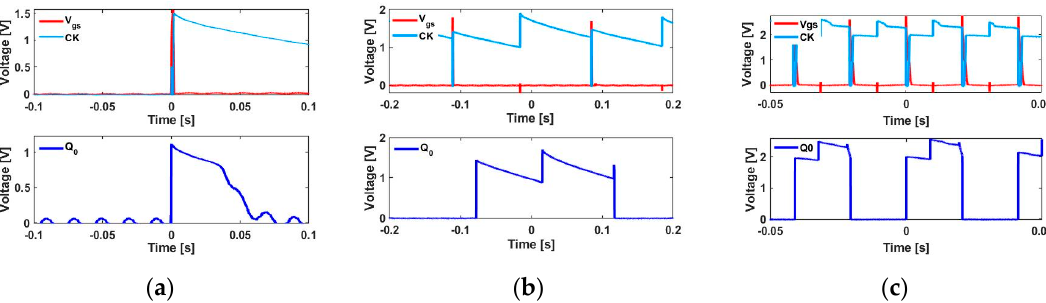
Figure 9. Experimental waveforms of the single-bit counter at various excitation frequencies using the diode bridge rectifier. The output Q 0 , clock signal (CK), and V gs of the single-bit D flip-flop (CD4013B) for ( a ) a single rotation and for rotational frequencies of ( b ) 5 and ( c ) 50 Hz.